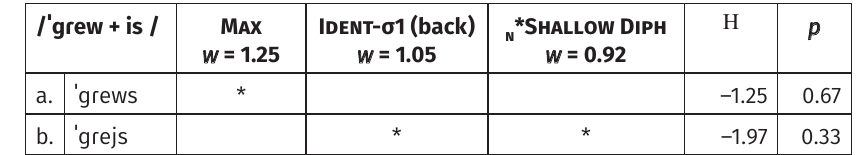
Table 9: The grammar with adult weights.